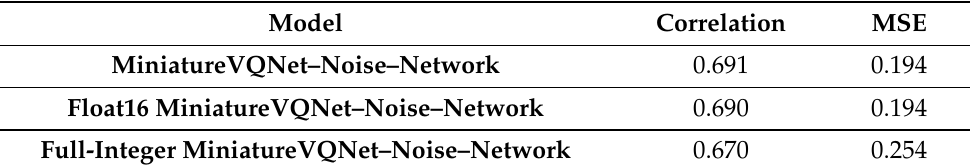
Table 2. Correlation and Mean Squared